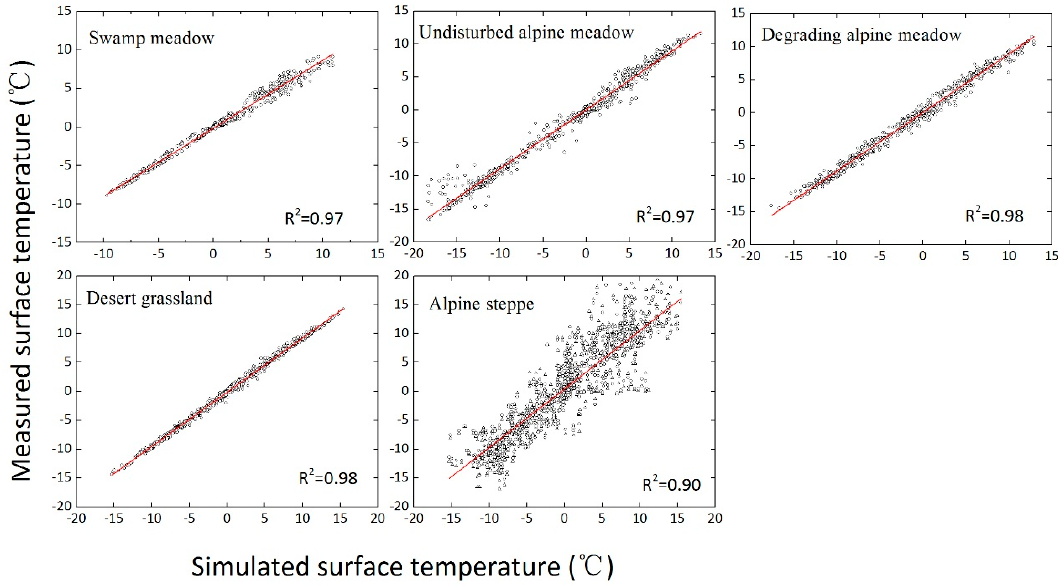
Figure 3. Scatterplot of the simulated and measured daily ground surface temperature for multiple field sites. Each graph includes one site with a land cover type.